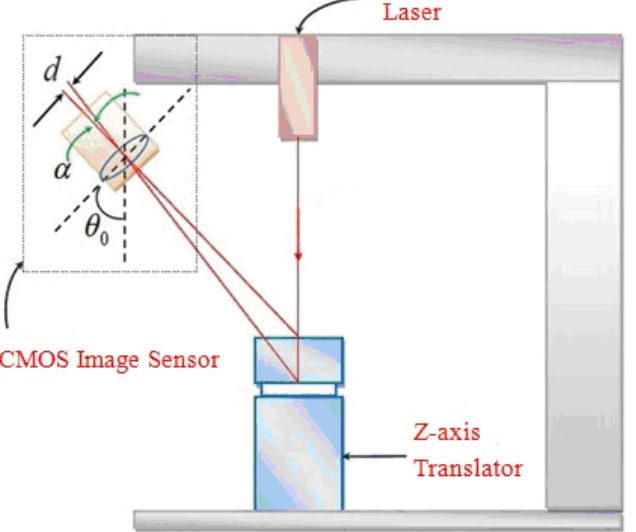
Figure 4. Schematic drawing of the linearity calibration of the Parkinson’s disease measurement system.